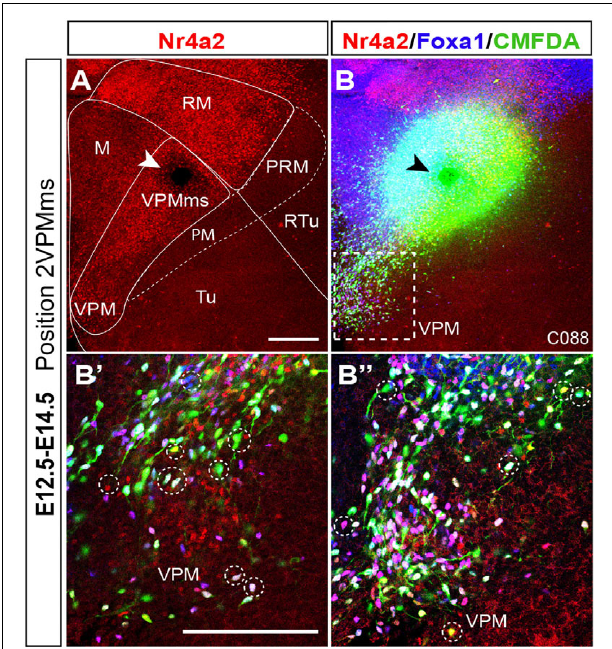
FIGURE 11 | Analysis of VPMms cell molecular diversity. (A) Nr4a2 immunoreacted E12.5–E14.5 case marked with CMFDA at the initial part of VPMms (arrowhead indicating grain site). Relevant areal boundaries and areas are indicated. (B) Same case showing green fluorescent CMFDA labeling of the VPMms, as well as blue Foxa1 immunoreaction. (B’,B”) Higher magnification medial and lateral 3 µ m-thick confocal optic sections from (B) taken from the boxed-in area in (B) . The diverse possible combinations of markers obtained in individual VPMms neurons result in different fluorescent colors sampled in both images by discontinuous circles; Nr4a2 + CMFDA (yellow), Foxa1 + CMFDA (light blue), Nr4a2 + Foxa1 + CMFDA (white), CMFDA + other RM gene markers not analyzed (green). Scale bars represent 200 µ